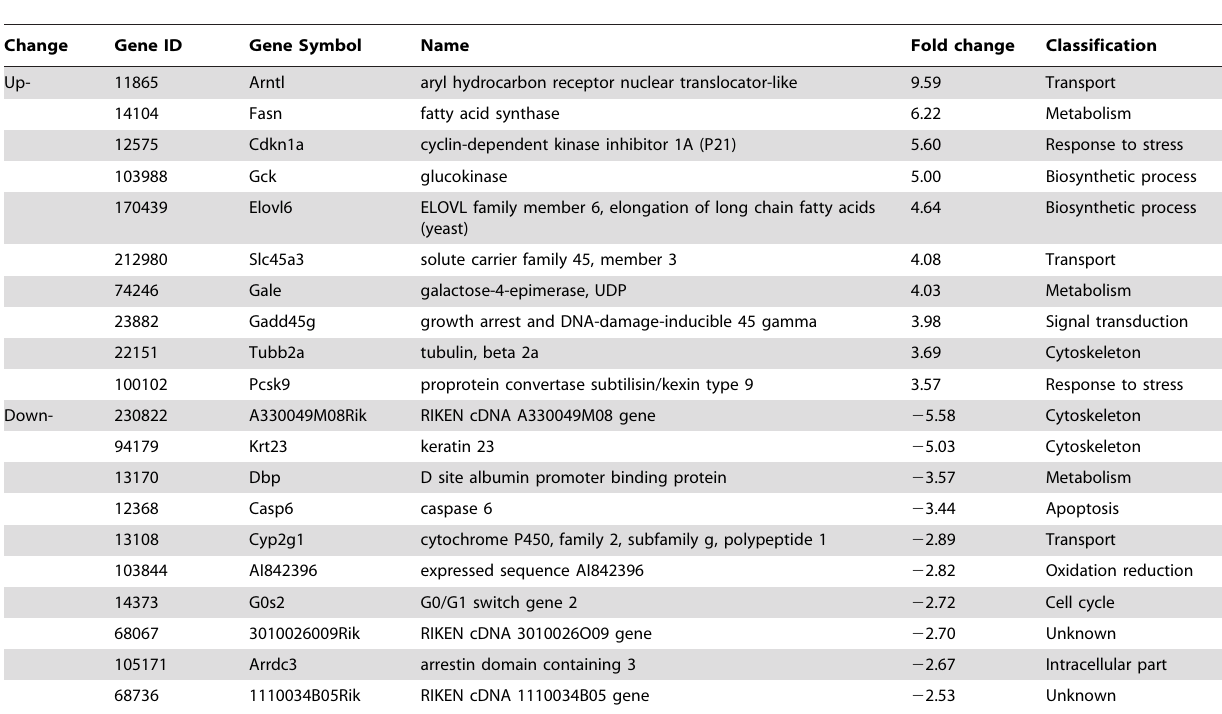
Table 2. Top 10 up- or down-regulated differentially expressed genes and their GO clustering classification at 2 months after intrahepatic injection of E.multilocularis metacestode (infected mice), compared to intrahepatic injection of saline (non-infected